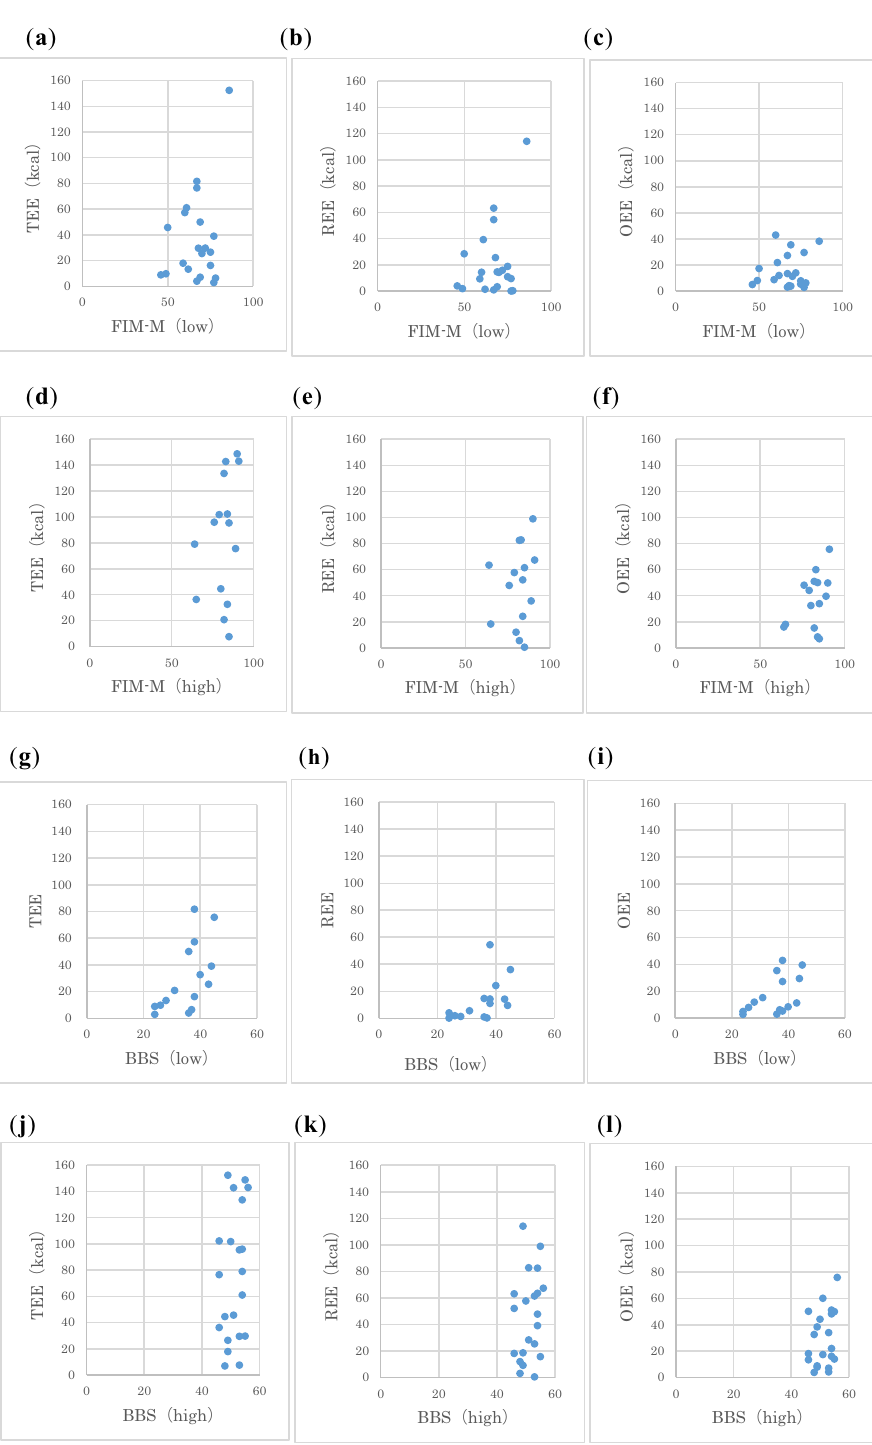
Figure 2. Scatter plots of physical function (high and low score groups of FIM-M and BBS) and energy expenditure. Scatter plot of FIM-M (low-score group, n = 21) and ( a ) TEE, ( b ) REE, and ( c ) OEE. Scatter plot of FIM-M (high score group, n = 15) and ( d ) TEE, ( e ) REE, and ( f ) OEE. Scatter plot of BBS (low score group, n = 15) and ( g ) TEE, ( h ) REE, and ( i ) OEE. Scatter plot of BBS (high score group, n = 21) and ( j ) TEE, ( k ) REE, and ( l )